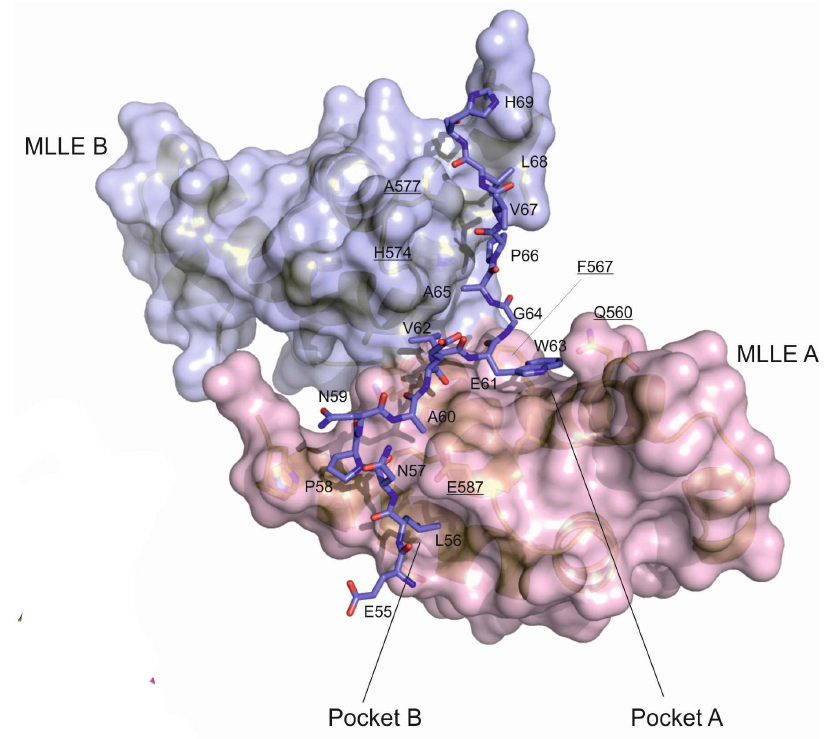
Figure 2. Surface representation of MLLE molecule A (pink) and B (blue) with the bound LARP4B–PAM2w peptide, shown as a stick model. MLLE residue names are underlined. (blue) and C (green).